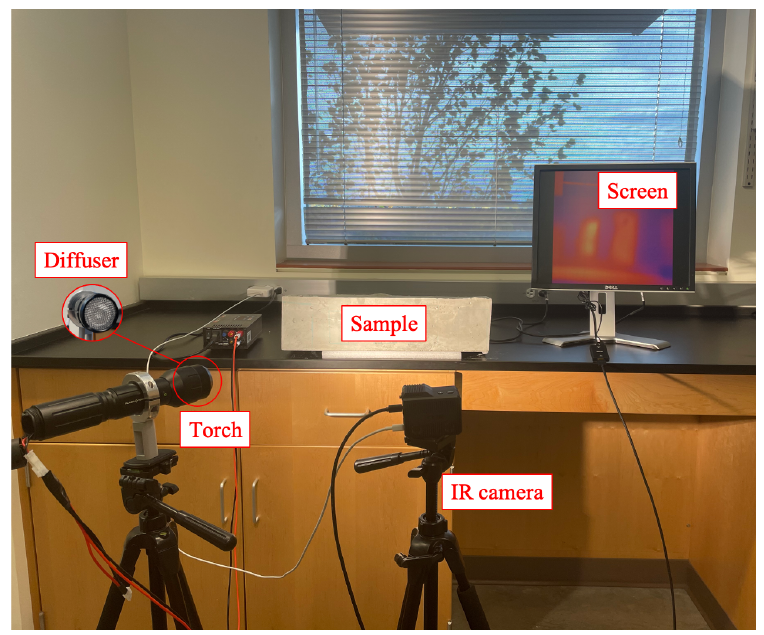
Figure 3. Test setup.